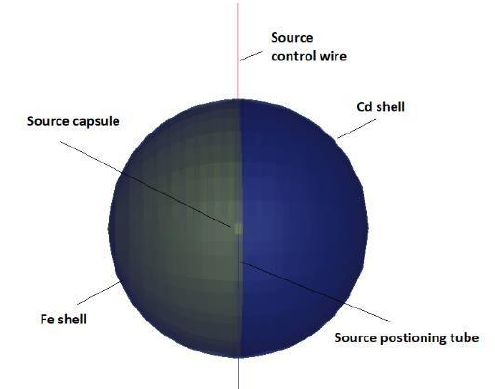
Fig. 1. 3D MCNP6 geometrical model of the D 2 O- 252 Cf assembly at